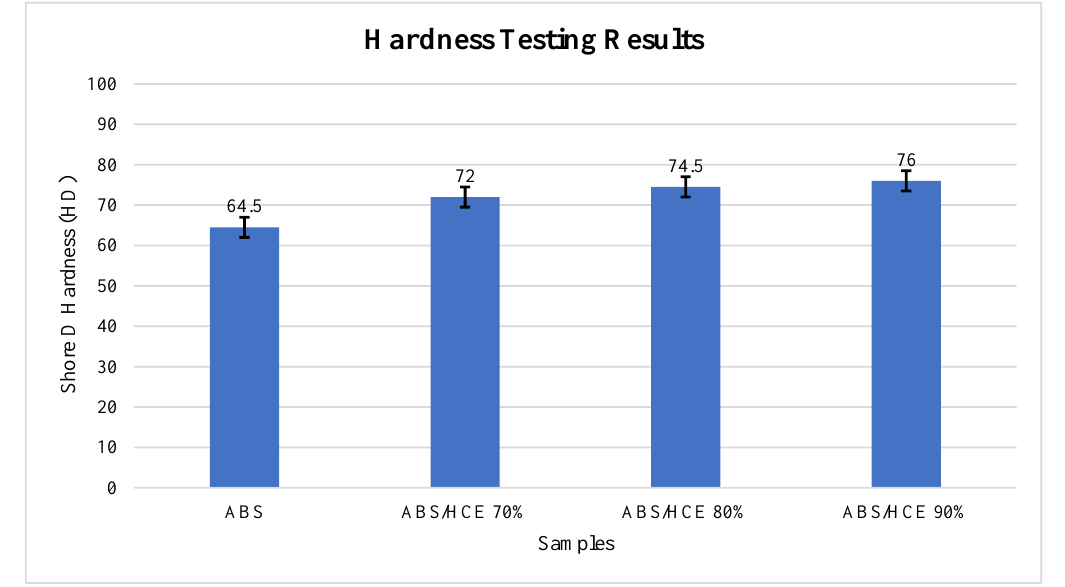
Figure 21. Hardness testing results for ABS/HCE composites with ABS. Figure 22 shows the hardness results of ABS/GEP composites with ABS. A single layer of GEP with 0.2 wt.% GNPs added at 70% to ABS showed 75 HD, an increase of